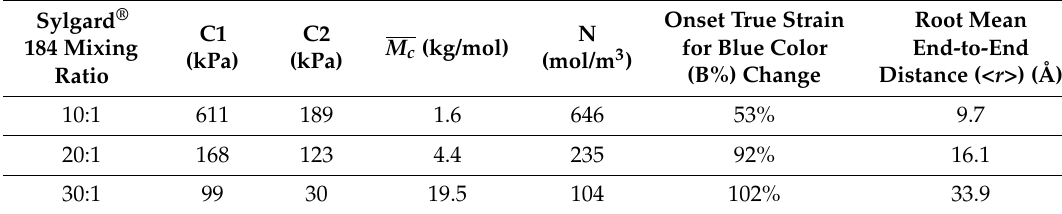
Table 1. Effect of mixing ratio on the structure and performance of PDMS network structure. Tensile test strain rate was 0.014 s − 1 .